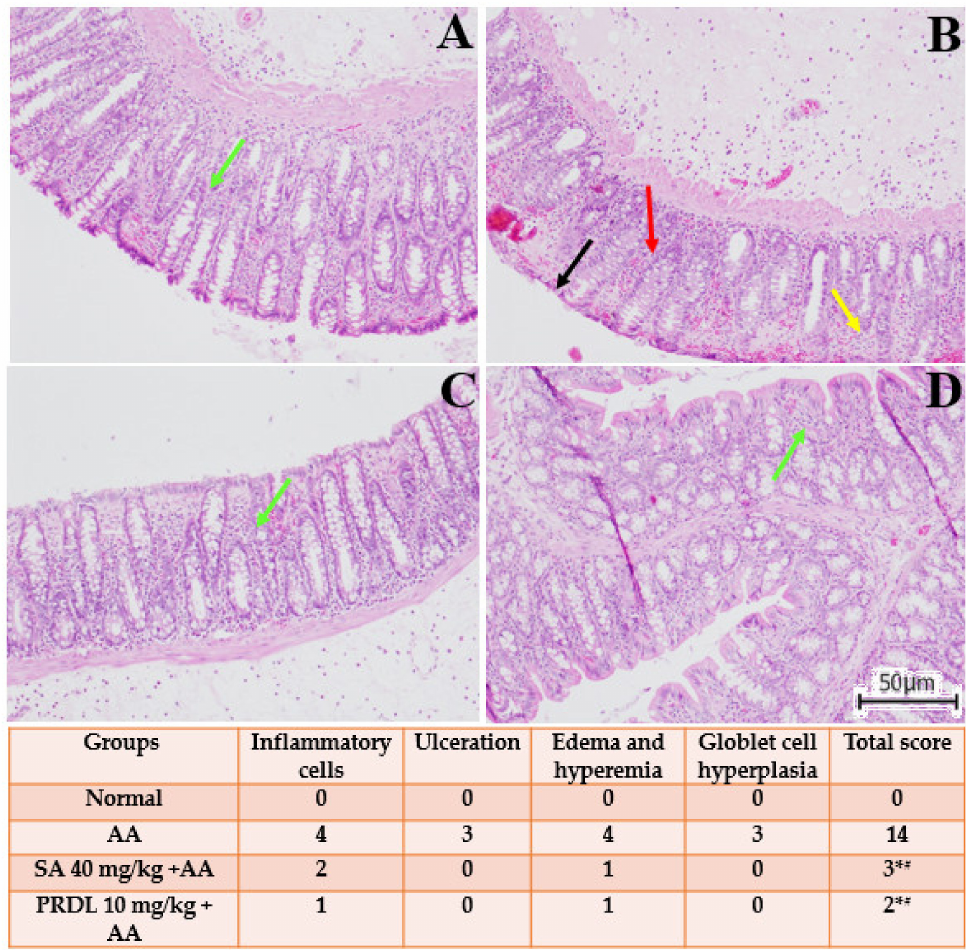
Figure 6. Histopathological observations along with their intensity. Histological colonic sections of a normal rat showing normal mucosa (green arrow) ( A ). Animals in AA group showing active colitis with stromal edema, superficial erosions (black arrow), inflammatory cell infiltration (yellow arrow) with broadly ulcerating mucosa (red arrow) ( B ). SA 40 mg/kg + AA group animals showing ameliorative epithelial changes with ulcer healing and inflammatory cells along with lymphoid follicle (green arrow) ( C ). Animals in (PDRL 10 mg/kg + AA) group exhibiting healing ulcer and attenuation of cell damage (green arrow) ( D ). The results are presented as mean ± SEM ( n = 6) per group. * denotes significant differences compared to the control group ( p < 0.05); # denotes significant differences compared to the AA group ( p <